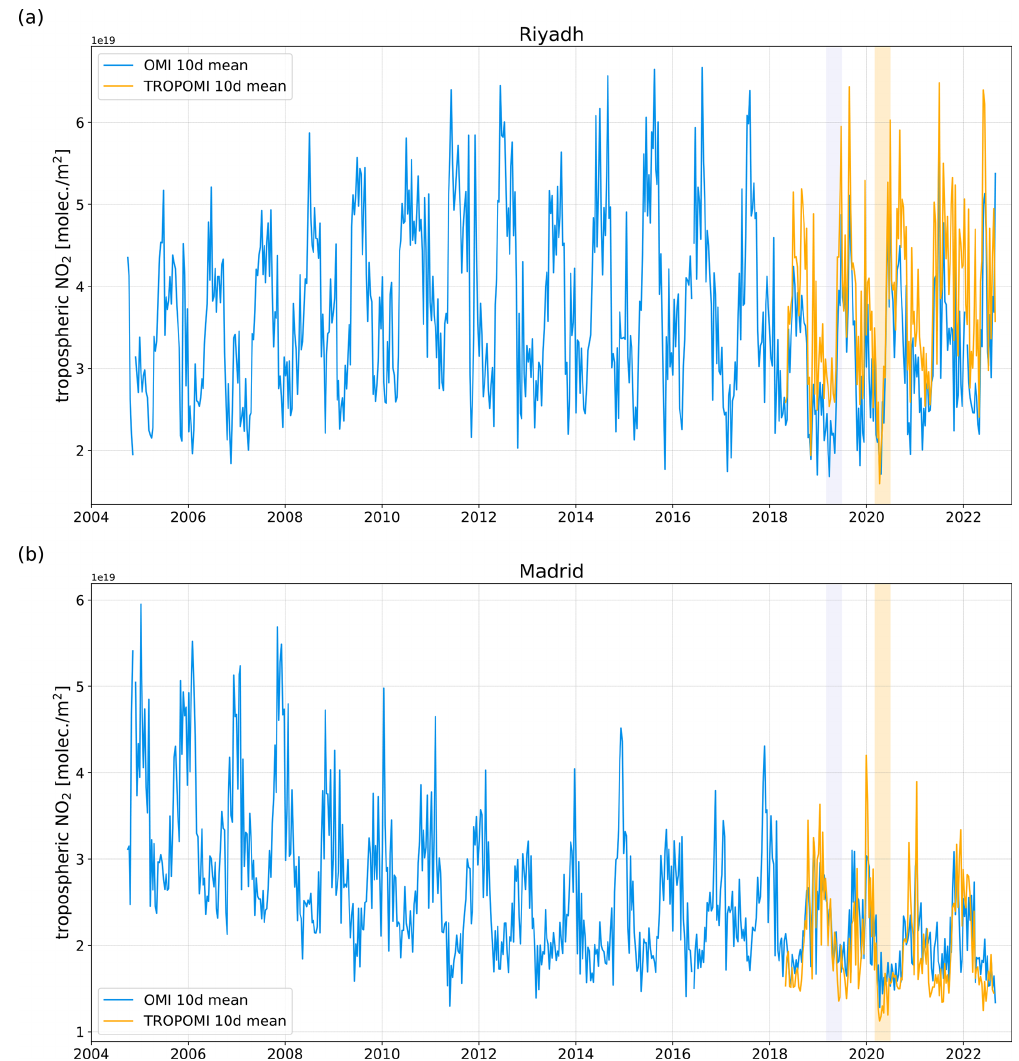
Figure A13. Time series of the TROPOMI and OMI tropospheric NO 2 columns in terms of the 10d mean in (a) Riyadh and (b) Madrid. The areas marked using lavender and orange colors are the study periods in 2019 and 2020,